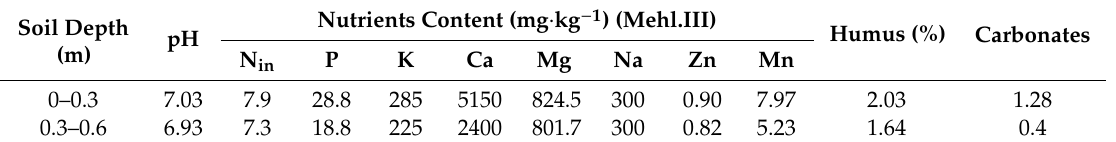
Table 1. Typical soil characteristic before autumn 2017 sunflower planting in the experimental locality (Dolná Malanta, Nitra, Slovak republic).